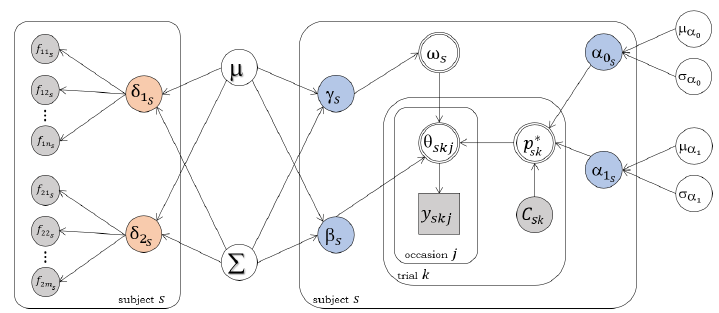
Figure 2. Covariance model’s architecture. Square and circular nodes indicate discrete and continous variables, respectively. Grey nodes indicate observed variables. Blue and red nodes represent behavioural and neural node parameters, respectively. Double-circled nodes represent deterministic